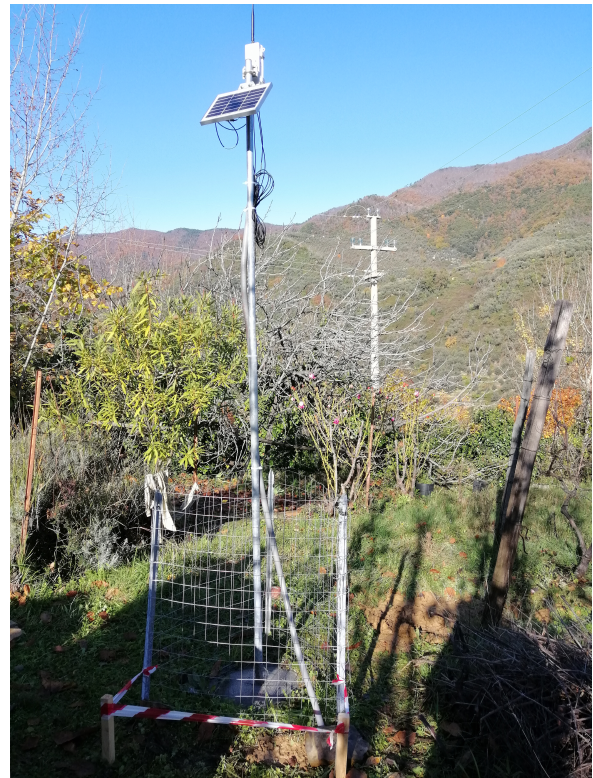
Figure 1. WaterScout SM100. Figure 2. Sensor Pup positioned in Ceriana.